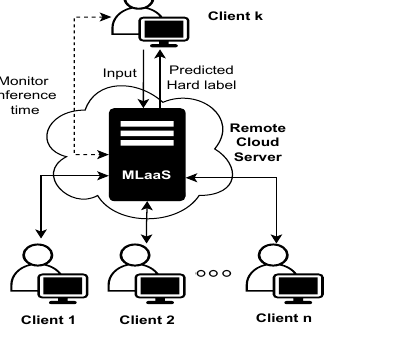
Table 2: Custom CNN Architecture for CI- FAR10 and CIFAR100. The filter size of Convolution layers and the number of neur- ons in Fully Connected layers are given after layer names. MaxPool’s Kernel size = 3x3 and Stride =